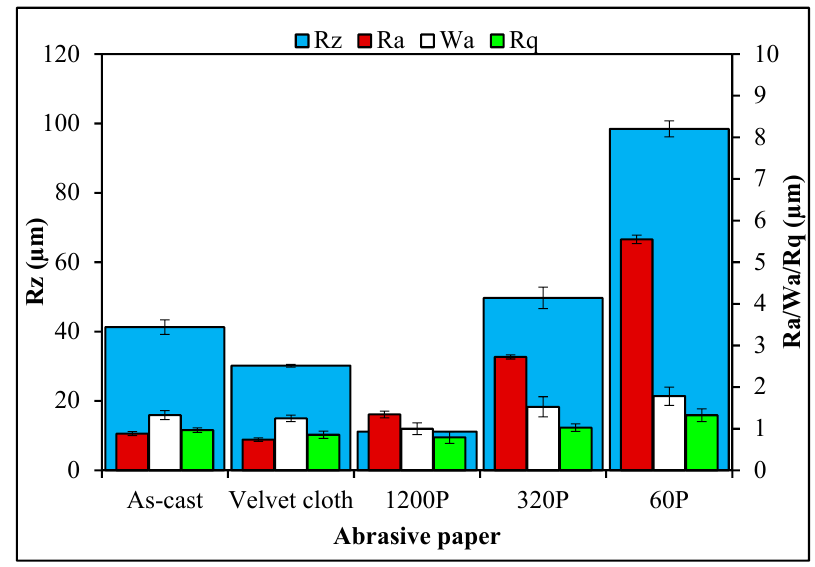
Figure 14. Topographical features of 0.05 wt % MLG-0.05 wt % clay-EP nanocomposites.